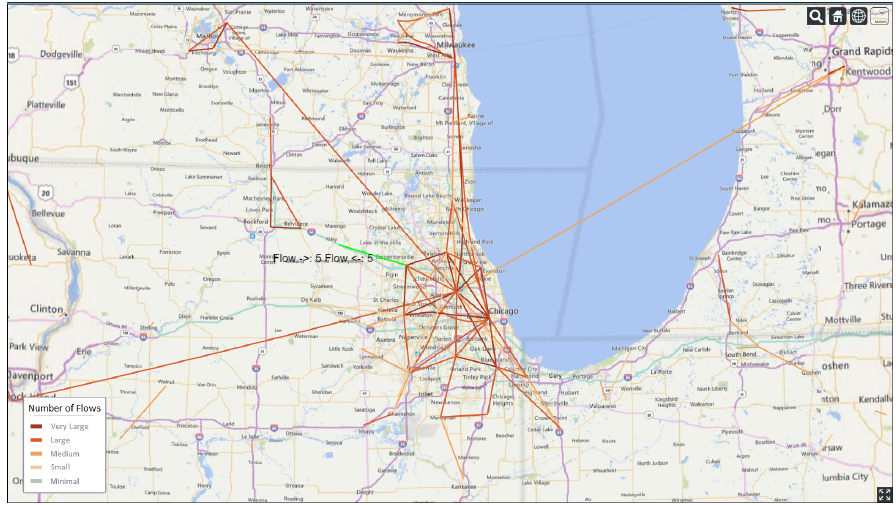
Figure 9. The top 20% movement flows around Chicago